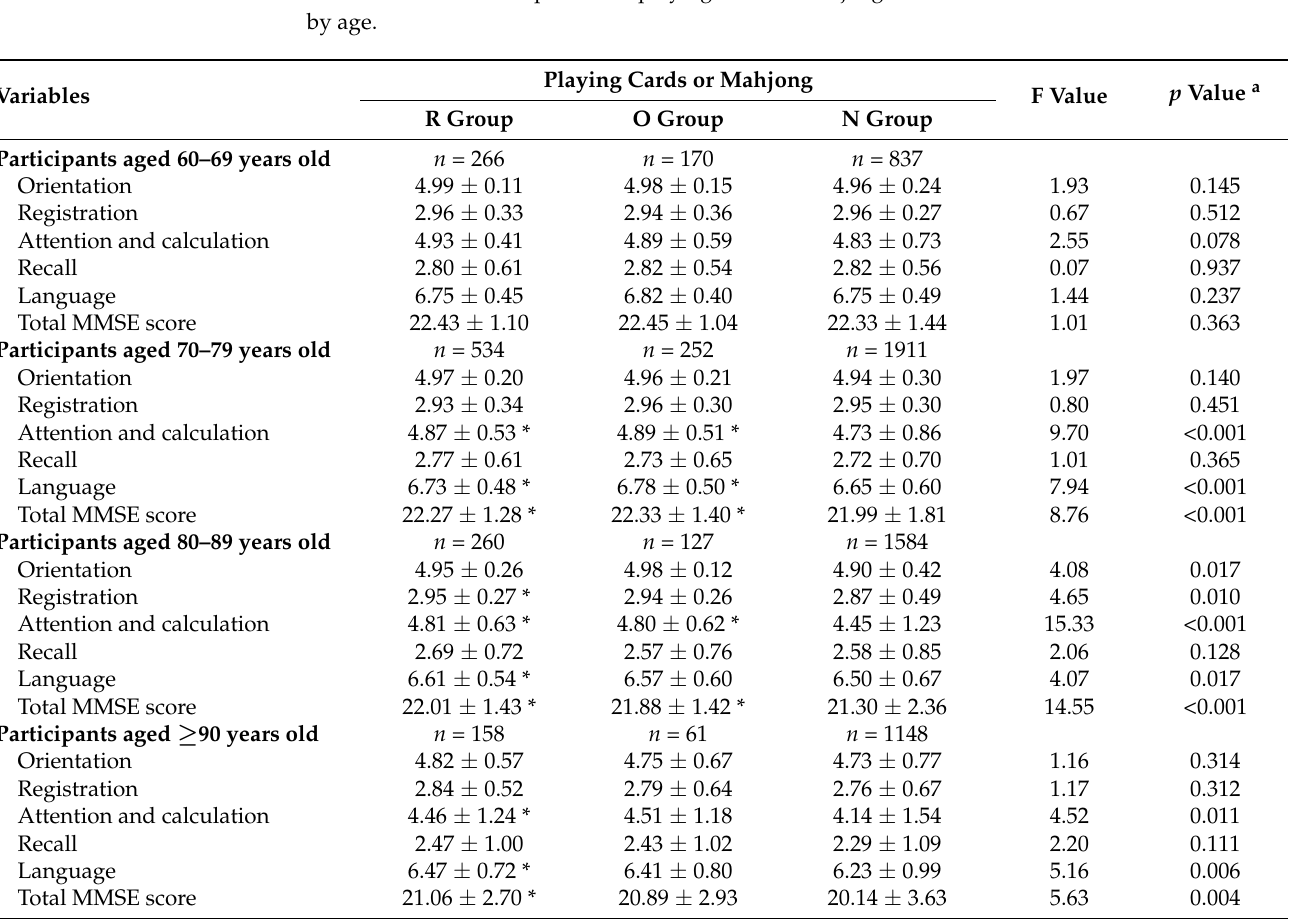
Table 3. The relationship between playing cards or mahjong and MMSE items in older adults stratified by